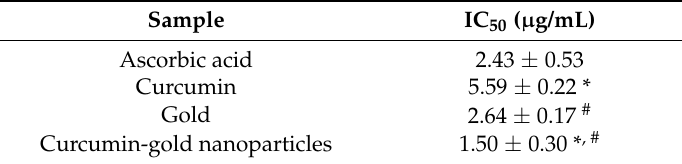
Table 2. IC 50 of ascorbic acid, curcumin, gold, and curcumin-gold nanoparticles.